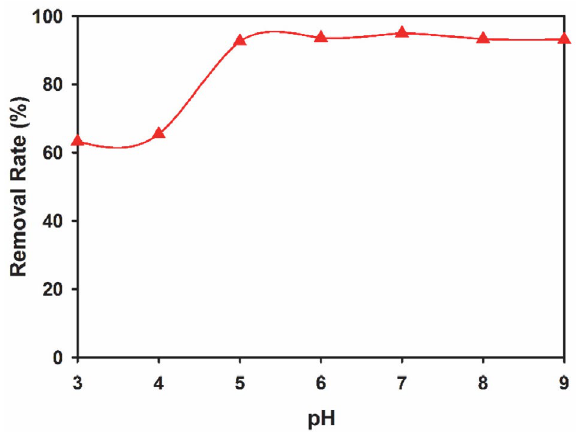
Figure 7. Effect of initial solution pH of Ni (II) ions on removal ef- ficiency.